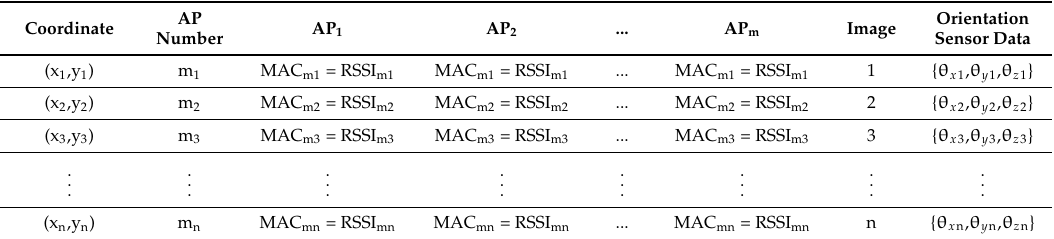
Table 1. Storage format of the